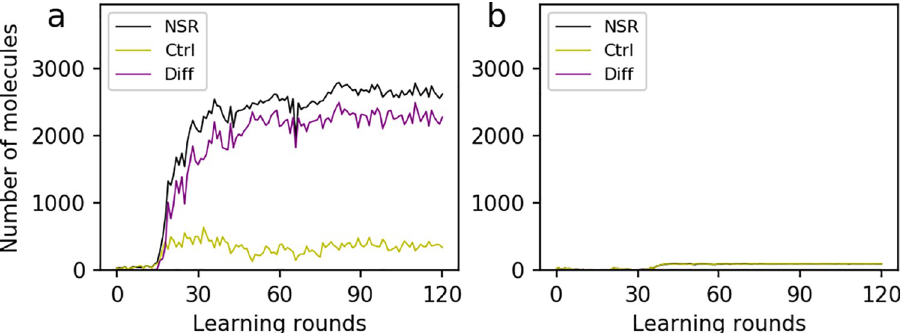
Fig 5. Adopting the difference between NSR and the control RNA species as the objective function. The starting value of parameters are the same as those in Fig 2A: i.e., PNF = 0.004, PNFR = 0.02, PND = 0.001, PRL = 2 × 10 − 5 , PBB = 1 × 10 − 5 , PAT = 0.5, PFP = 0.1, and PMV = 0.001. The learning rate e = 0.5. Here the objective function is the difference (Diff) between the number of NSR and the control RNA species (i.e. NSR—Ctrl), instead of the number of NSR per se . ( a ) NSR plays its normal role as it is named. ( b ) NSR is assumed to lose its function. In fact, in case b , the curve of NSR (black) is almost covered by that of Ctrl (yellowish-green) because there is nearly no difference between them throughout the whole learning process, and the curve of Diff (purple) lies very close to the horizontal axis.